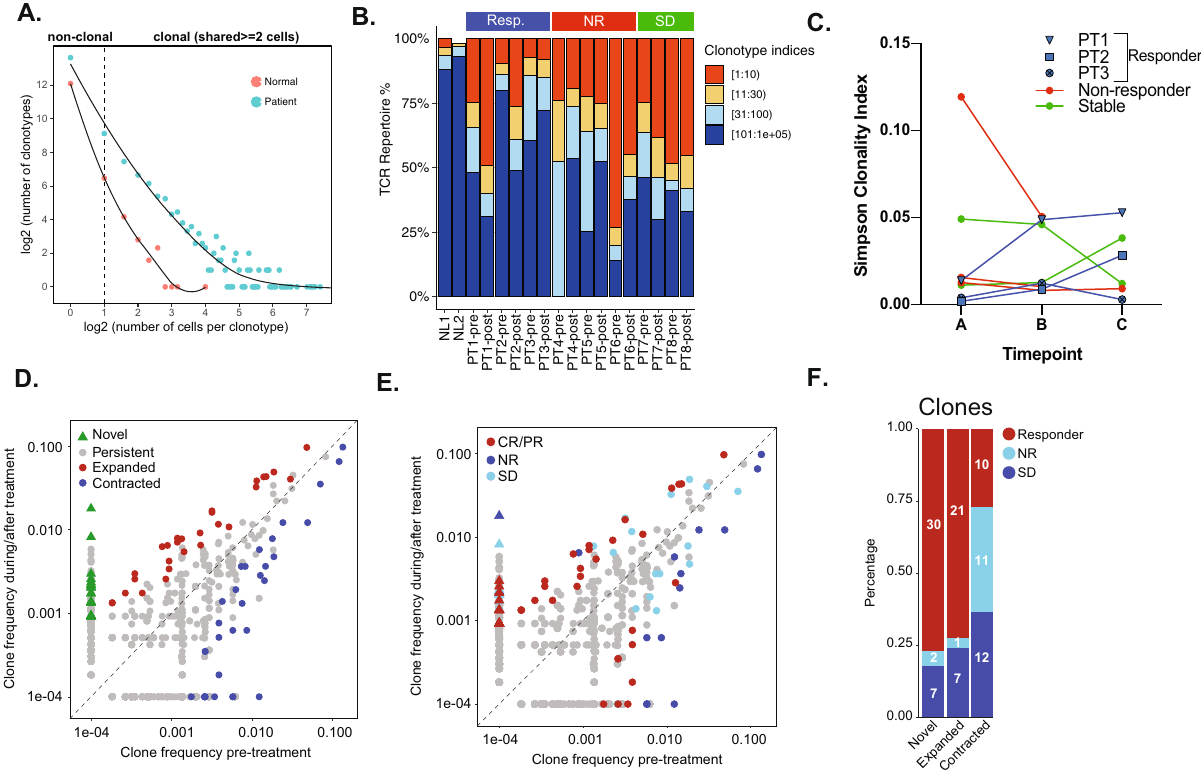
Fig. 2 T-cell receptor clonotype assessment across different patients and timepoints. A Scatterplot of the correlation between the number of T cell clonotypes and the size of the clonotype i.e. the number of T cells contributing to the clonotype. B Distribution of the most abundant clonotypes by patient. C Simpson ’ s clonality index of individual patients at each of their respective timepoints. D Scatterplots of clonotypes change of post- versus pre-treatment and E by response groups. F Number of novel, expanded and contracted clonotypes by response